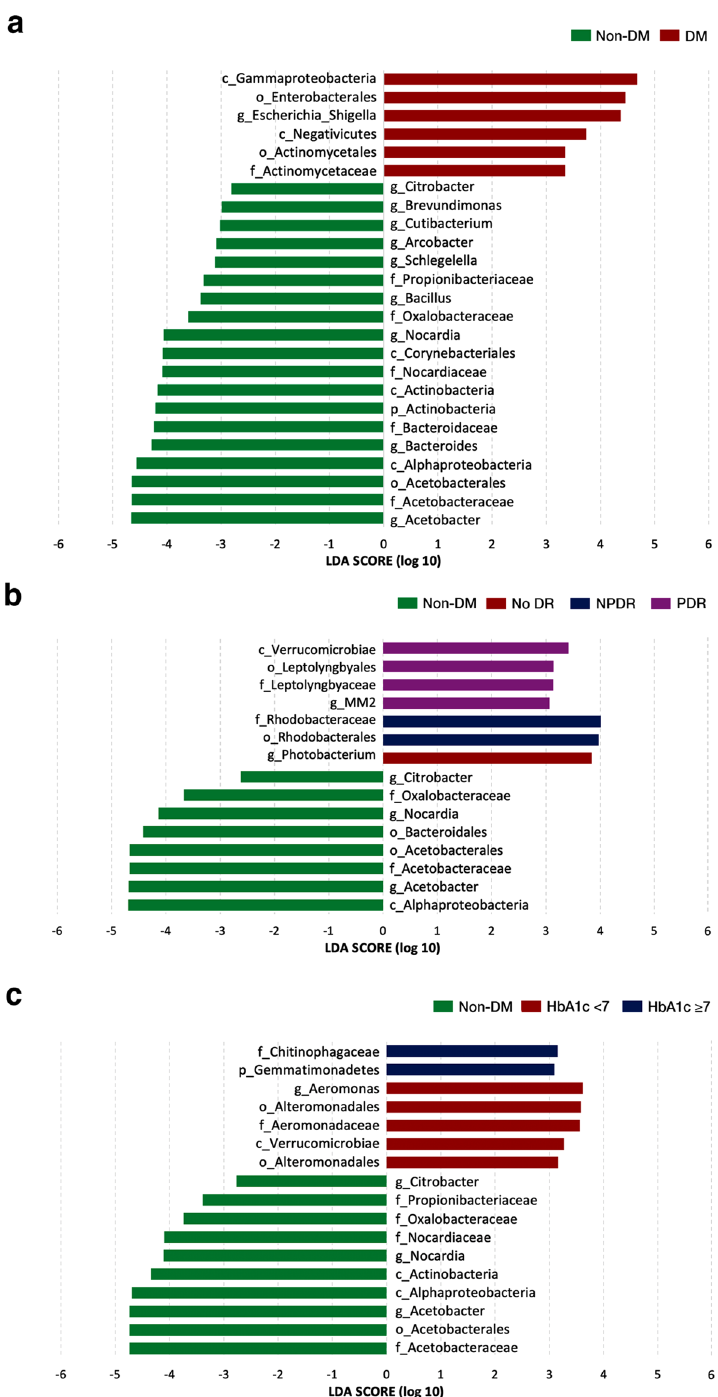
Figure 2. Linear discriminant analysis effect size (LEfSe) represents the significant difference in bacterial distribution between groups. Bacterial taxa with LDA scores greater than 2 were considered significant. ( a ) Comparison of taxa lists between the non-DM and DM groups. ( b ) Comparison of taxa lists between the non-DM and DM subgroups classified by DR staging. ( c ) Comparison of taxa lists between the non-DM and DM subgroups classified by glycemic control. (Abbreviations: p phylum, c class, o order, f family, and g genus, DM diabetes mellitus, Non-DM non-diabetes mellitus, No DR no diabetic retinopathy, NPDR non-proliferative diabetic retinopathy, PDR proliferative diabetic retinopathy, HbA1c hemoglobin